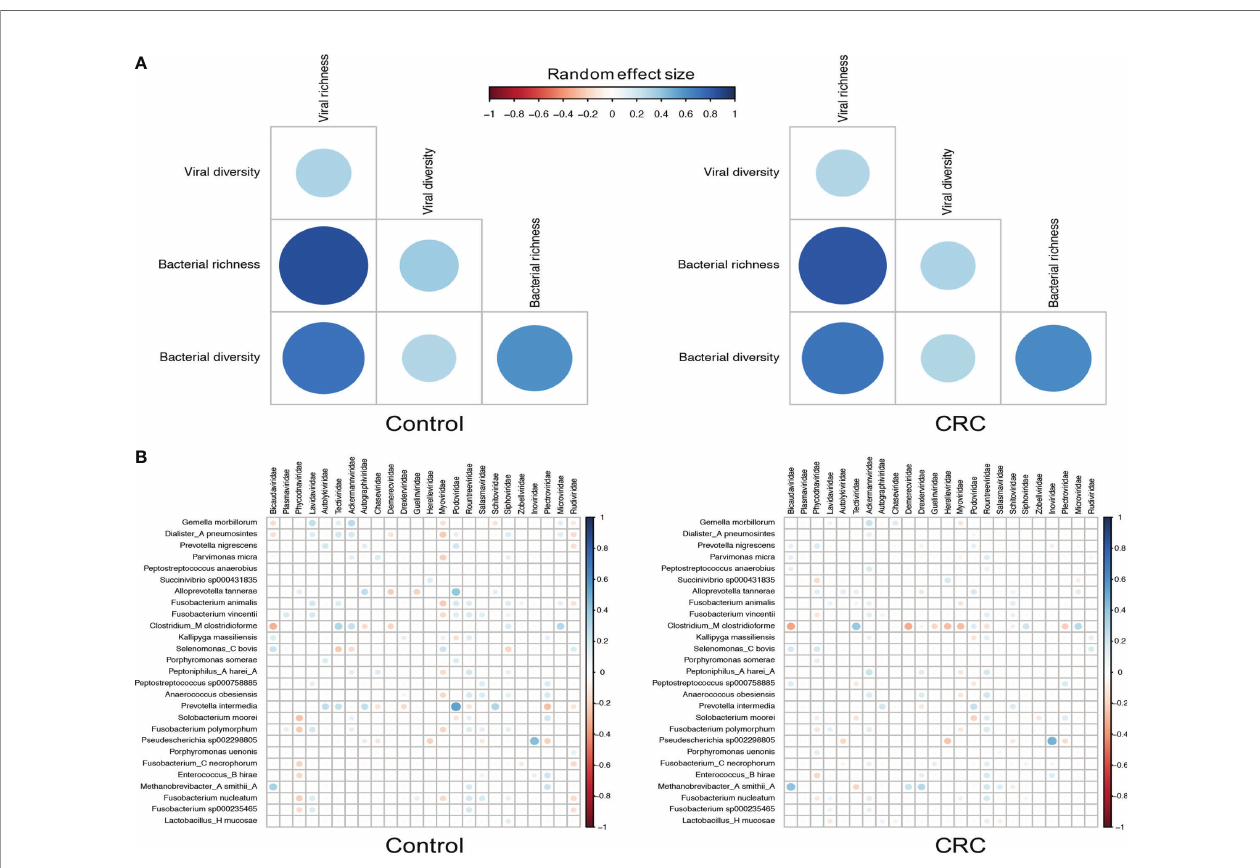
FIGURE 4 | Correlations between viral families and bacterial species. (A) Random effect size of Spearman ’ s correlation coef fi cients between the diversity and richness of bacteria and viruses in healthy controls and CRC subjects. Correlations with BH adjusted p-values <0.05 are displayed. (B) Random effect size of Spearman ’ s correlation coef fi cients between the abundance of all 24 viral families and that of 27 differentially abundant bacterial species. Correlations with BH adjusted p-values <0.05 are displayed. The size and color of circles indicate the extent of